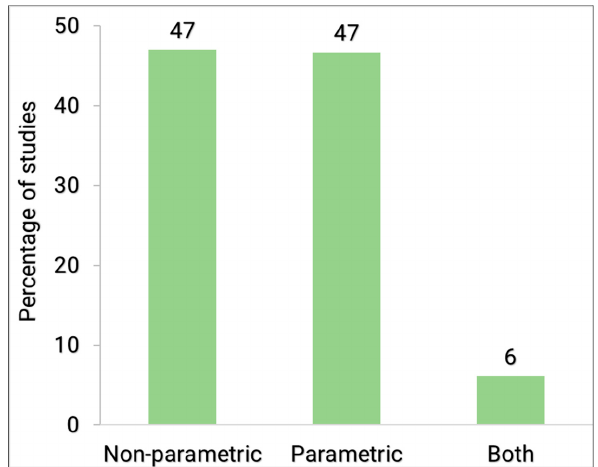
Figure 7. Methods category used to estimate the mixed pixel analysis